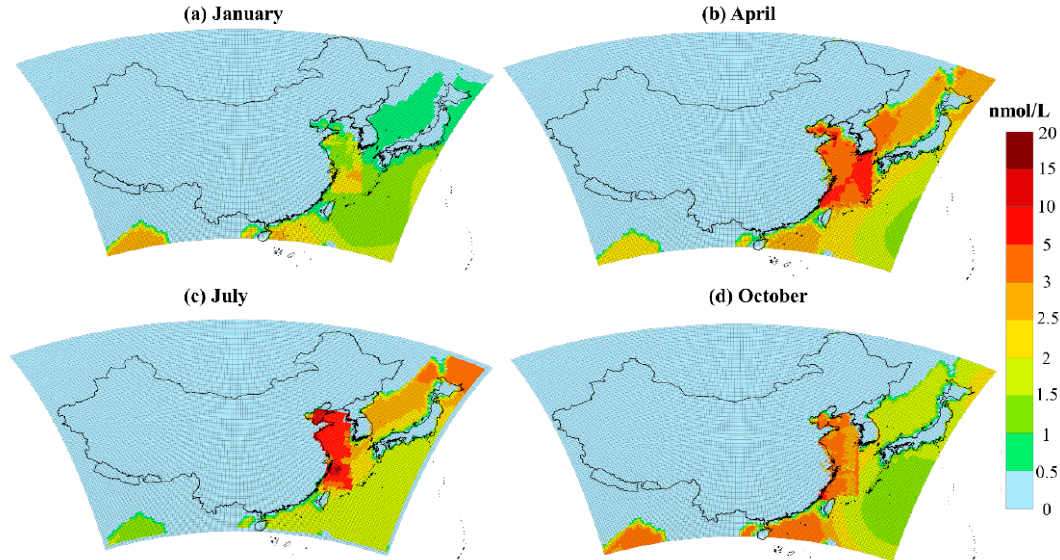
Figure 2. A national scale database of DMS (dimethyl sulfide) concentration—a multi-year observational record in the East China seas including the Yellow Sea, the Bohai Sea, and the East China Sea, and the data from the global DMS database is still used in the areas not covered by the observations. ( a ), ( b ), ( c ), and ( d ) represent the concentration distribution of DMS in seawater in January, April, July and October, respectively.